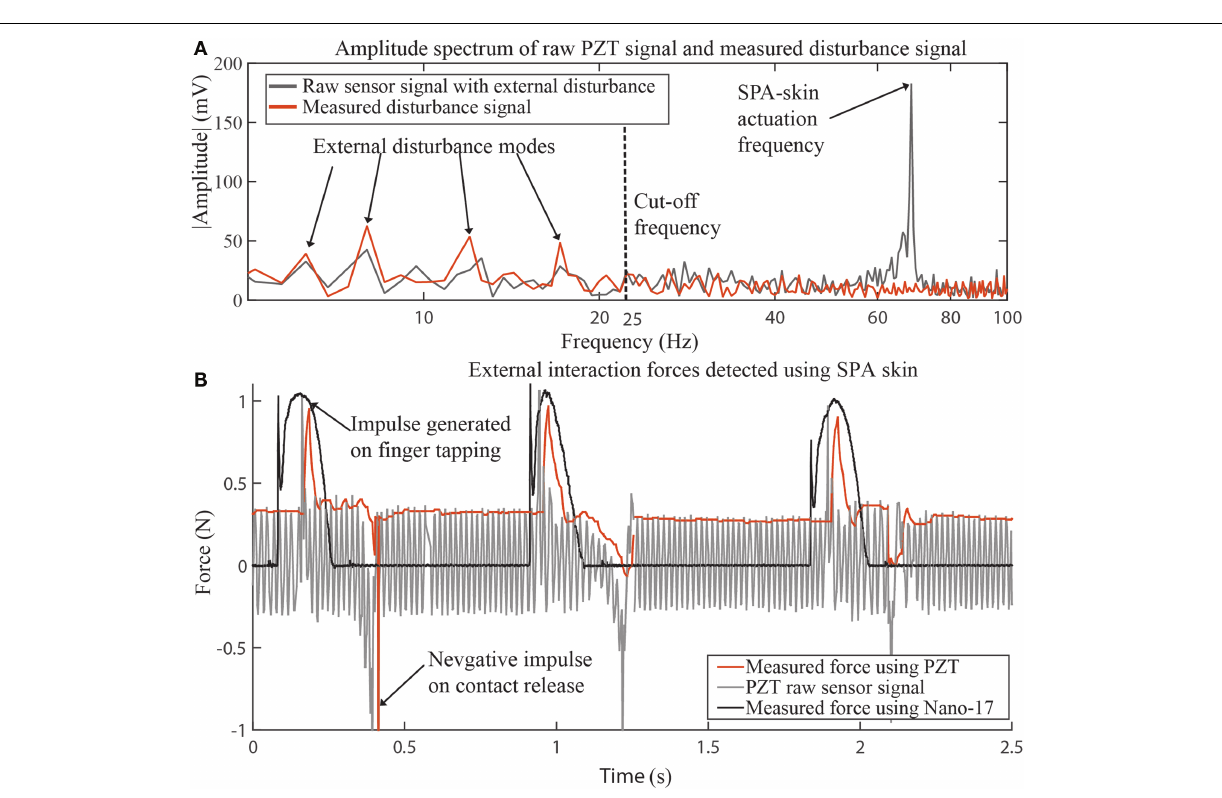
Frontiers in Robotics and AI |